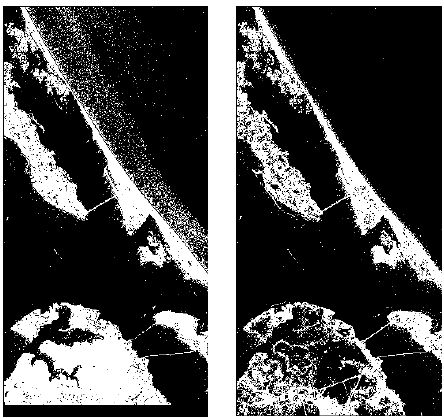
Figure 12 Validation Measurements on seashore site DUCK. Left: tie points repartition for B09-B10 couple. Right : tie points repartition for B05-B06